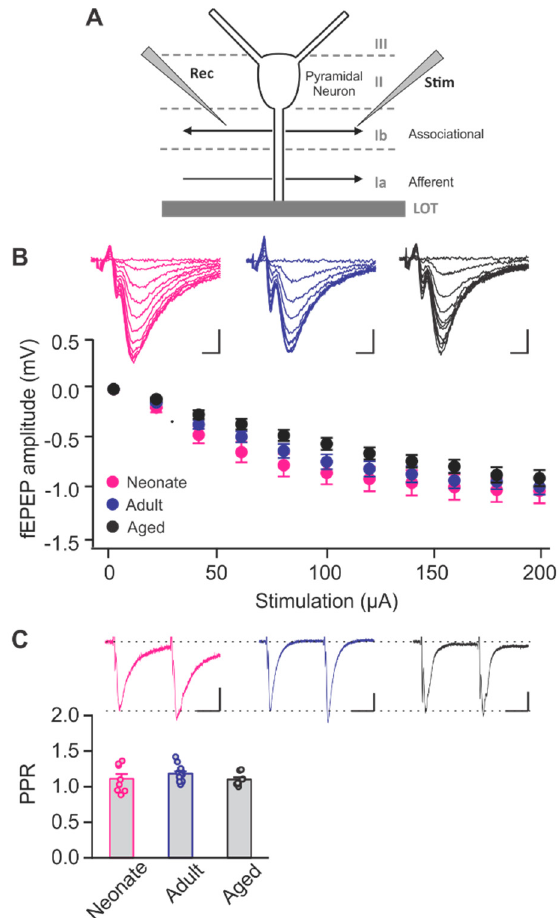
Figure 1. Input/output relationship and release properties of piriform layer Ib at different ages. ( A ) Schematic of the piriform cortex layers and recording configuration. ( B ) Input (stimulation inten- sity) vs. output (fEPSP peak amplitude) relationship in layer Ib. Example traces from different ages are shown in the upper panel. Neonate: n = 15; Adult: n = 12, Aged: n = 16. Scale bars, 0.5 mV, 2 msec. ( C ) Paired pulse ratios (PPRs) of fEPSPs at different ages. Neonate: n = 8; Adult: n = 13, Aged: n = 8. Scale bars, 0.2 mV, 20 msec. Stimulation artifacts were truncated in all example traces.